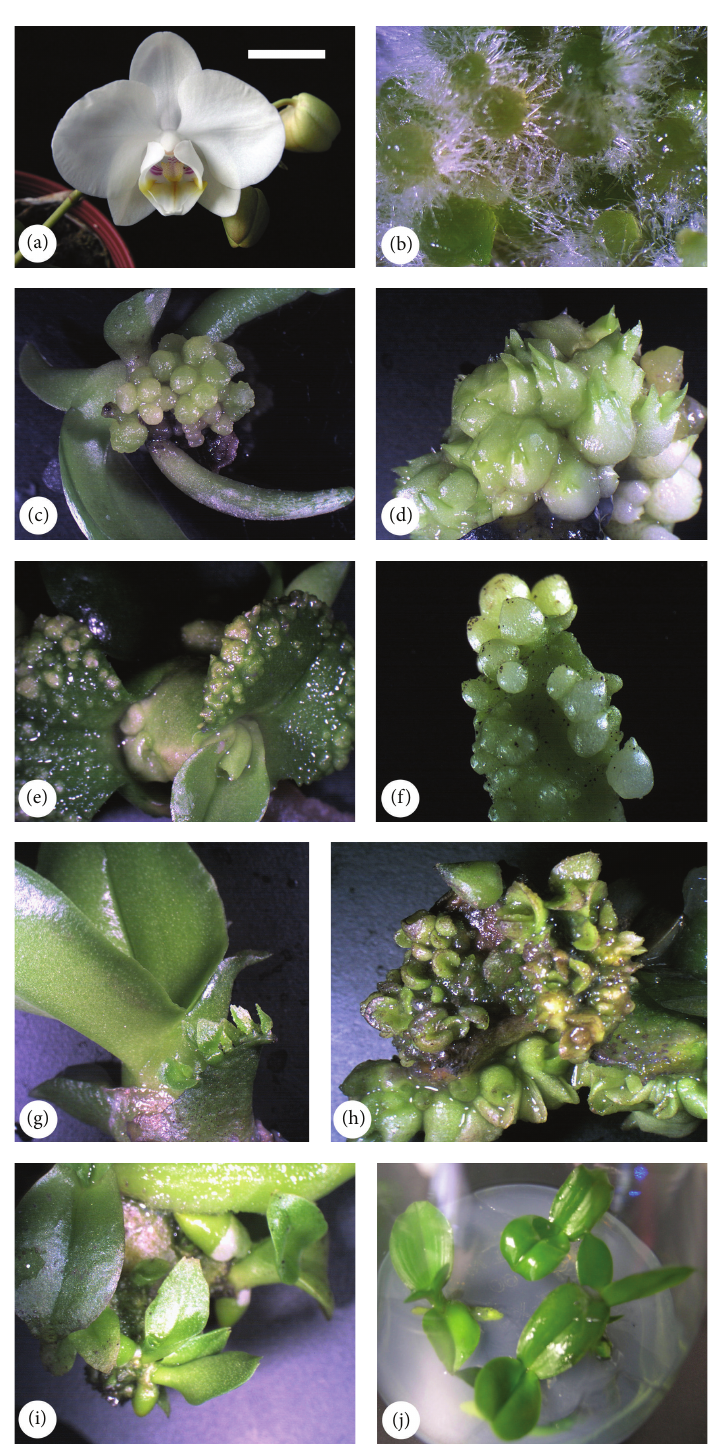
Figure 1: The donor plants of P. aphrodite subsp. formosana , their seed germination, and direct somatic embryogenesis from intact seedlings. (a) A flowering potted plant for self-pollination to obtain seeds ( bar 1.5 cm). (b) In vitro seed germination after 1 month of sowing on 1/4 MS medium ( bar 1mm). (c) A cluster of embryos originated from the posterior region of a 2-month-old seedling ( bar 3mm). (d) The embryos turned into protocorm-like bodies ( bar 2.5 mm). (e) The early event of embryogenesis originated from the leaf surface of a 2-month-old seedling ( bar 3.5 mm). (f) The foliar embryos formed from an intact 2-month-old seedling ( bar 2mm). (g) The foliar embryos developed leaves while they were still connected with the first leaf of the parent seedling ( bar 5mm). (h) Numerous embryos initiated from almost the entire seedling (bar = 4mm). (i) Plantlet conversion while the embryos were still on the parent seedling ( bar 4.5 mm). (j) Two-month-old rooted plantlets were successfully established ( bar